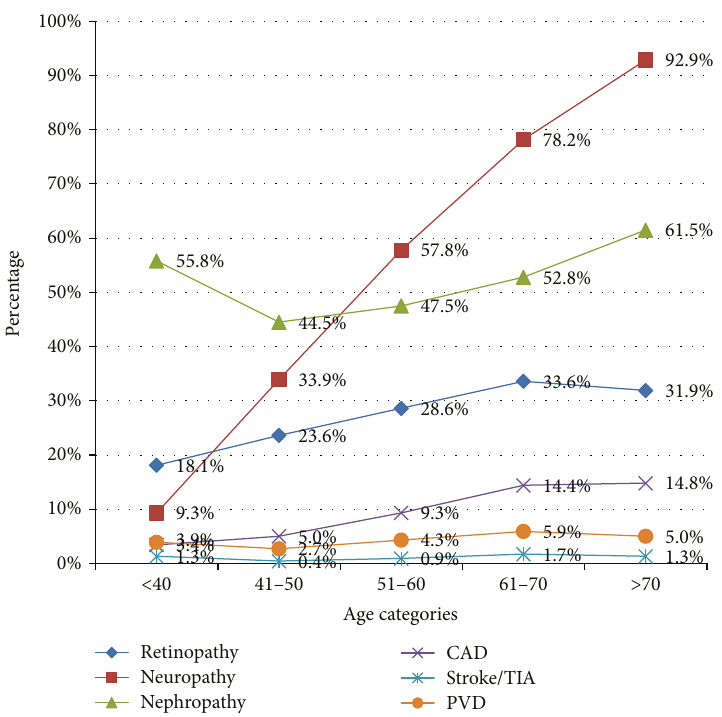
Figure 2: Variation of chronic complications with age among 3000 patients with type 2